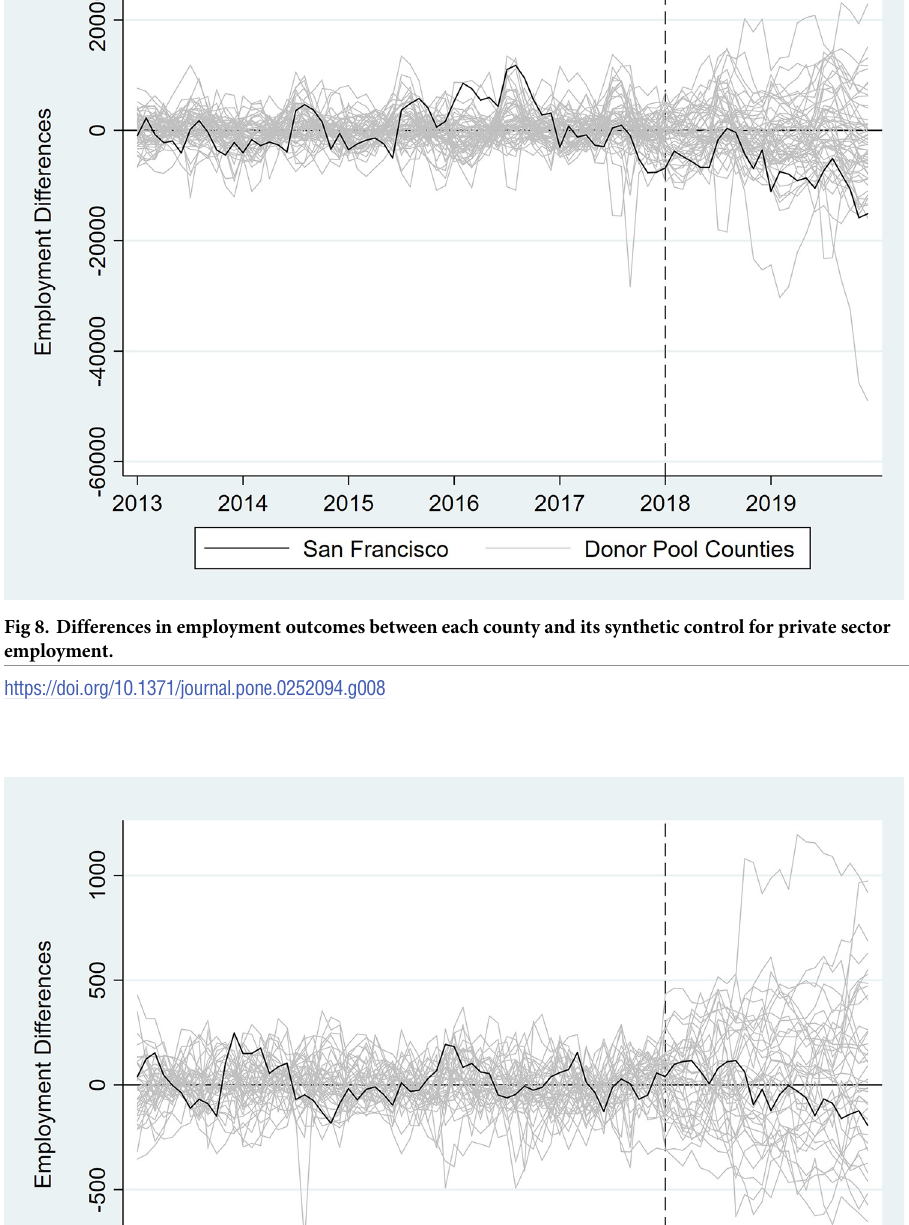
PLOS ONE | https://doi.org/10.1371/journal.pone.0252094 June 2,